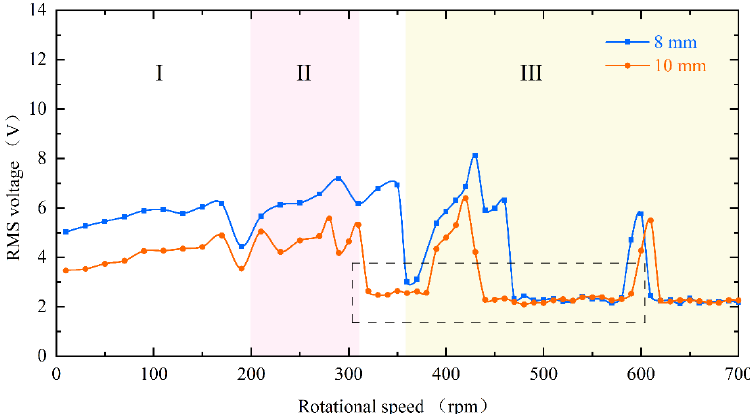
Figure 8. Experimental results of RMS voltage for the inverse beam at magnet spacing of 8 mm (blue line) and 10 mm (red line).